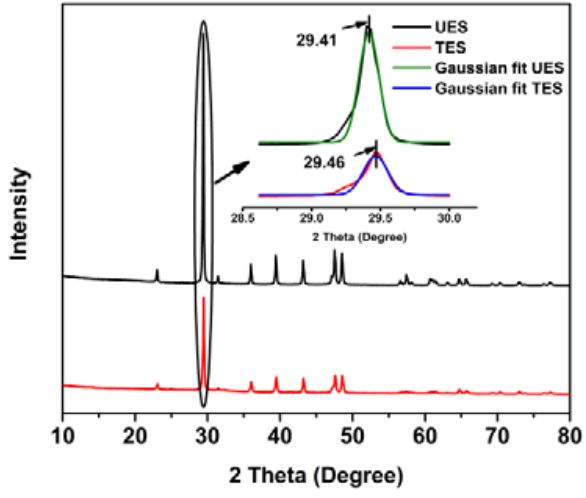
Figure 2. XRD of UES and TES particles.